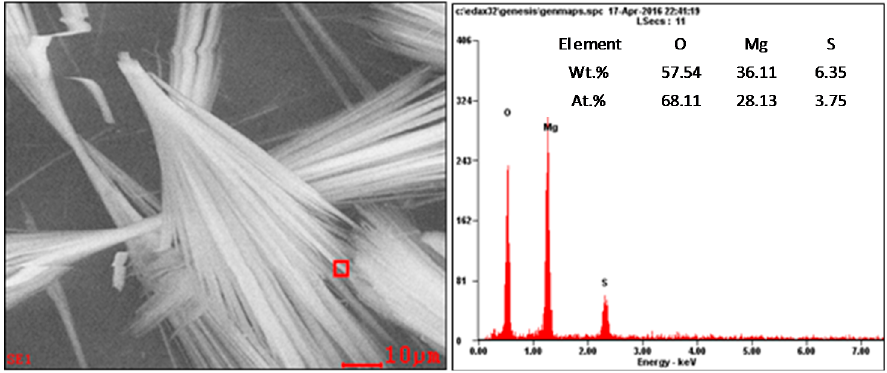
Figure 16. EDS spectra of the hydrothermal product.